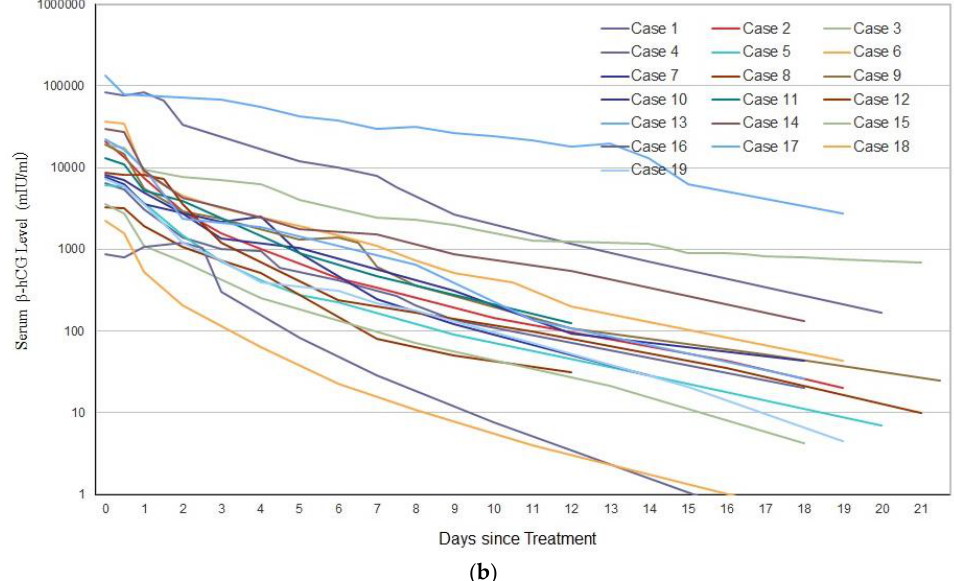
Figure 1. ( a ) Percentage change in the serum beta-human chorionic gonadotropin (β-hCG) level after chorionic villi-targeted therapy with absolute ethanol (CV-T therapy with AE) in 19 patients with cervical pregnancy. The x -axis shows days post-treatment; the y -axis shows the percentage of baseline serum β-hCG level. In all patients, the serum β-hCG level decreased to < 50% of the initial level within 3 days and to < 10% within 9–14 days. ( b ) Change in serum β-hCG level on a logarithmic scale. While the x -axis shows the number of days post-treatment, the y -axis shows the β-hCG level (mIU/mL). In all but one patient (with cervical pregnancy), the β-hCG level decreased to < 10 mIU/mL within 27 days of the treatment and to < 1.0 mIU/mL within 40 days. Biomedicines 2020 , 8 , x FOR PEER REVIEW